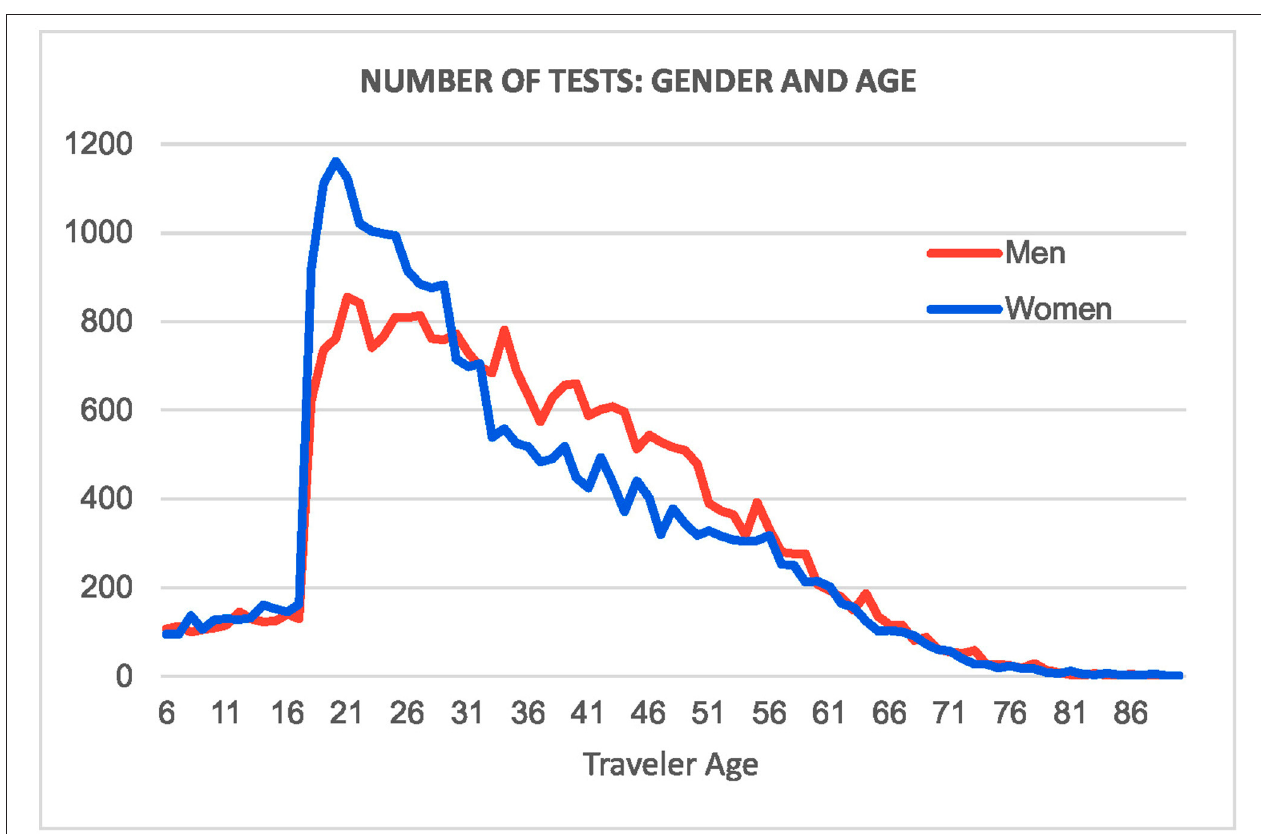
FIGURE 1 | Gender and age of studied